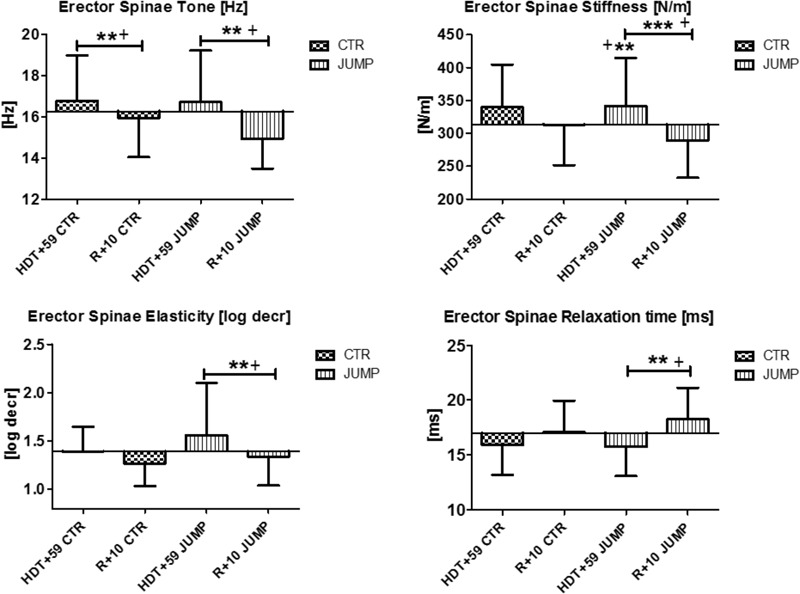
Erector spine (MP11/12). Oscillation signal patterns in RSL bed rest study. P-values (asterisks) refer to each graph. Error bars = SD (standard deviation). ABD = Average baseline data (Tone HDT+1 = 16.27; Stiffness HDT+1 = 313.48; Elasticity HDT+1 = 1.39; Relaxation HDT+1 = 17.0). ∗∗p < 0.01, ∗∗∗p < 0.001 ± SD, +Spearman ρ.